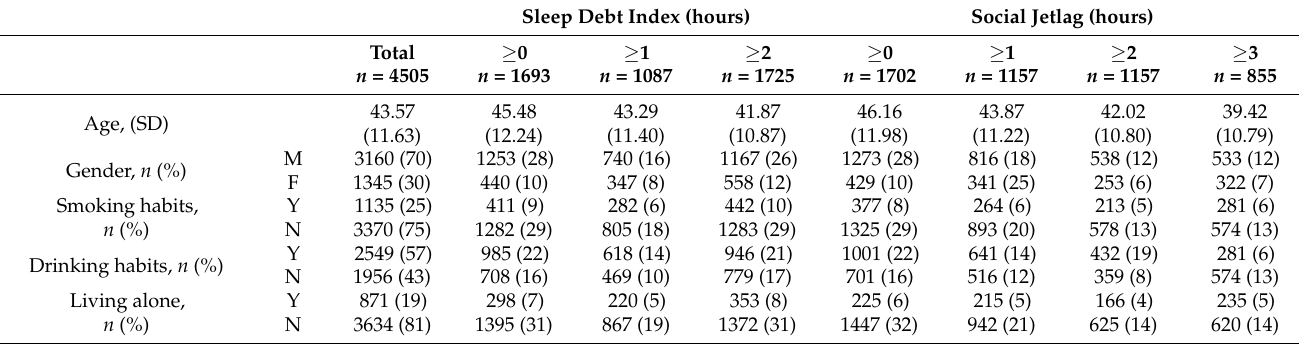
Table 1. Demographic data of the sleep debt index and social jetlag sub-categories.